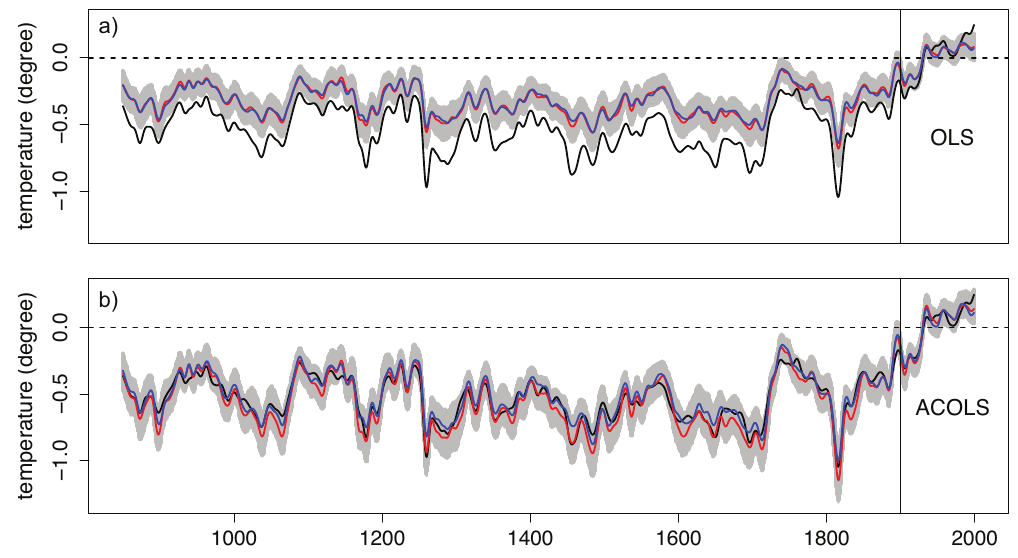
Fig. 2. CPS (blue) and multiple (red) regression reconstructions of NH mean temperature (10-year Gaussian smoothed results for visualization – high-resolution reconstructions are available in Supplementary Information, see http://www.clim-past.net/6/273/2010/ cp-6-273-2010-supplement.pdf) based on a network of twelve grid-points – comparable to Hegerl et al. (2007) – here subsampled from output of a coupled GCM (Ammann et al., 2007) where the true climate is known: (a) attenuated results from uncorrected OLS regression, and (b) the reconstructions from ACOLS. The vertical line at “1900” separates the calibration period from the reconstruction. Gray shaded area represents the 95% confidence interval (following Li et al.,